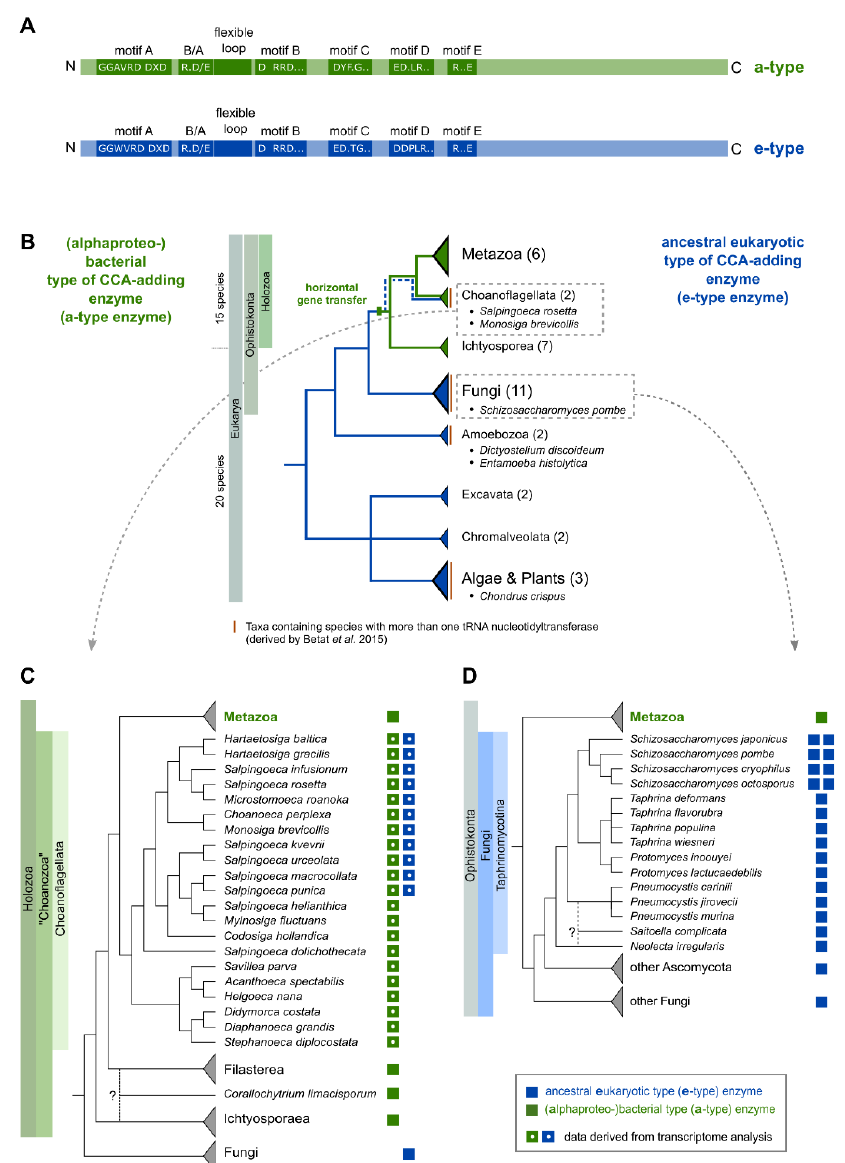
Figure 1. Phylogenetic distribution of eukaryotic species bearing genomes with more than one tRNA nucleotidyltransferase gene. ( A ) Schematic representation of class II tRNA nucleotidyltransferase organization. Motifs A to E of the catalytic core are indicated in green and blue. Additional motifs involved in A-addition are the basic / acidic motif (B / A; indicated as R (arginine) and D (aspartate), other basic / acidic combinations are also found) and the flexible loop, both located between motifs A and B. ( B ) Phylogenetic tree summarizing the data from 35 eukaryotic genomes analyzed in Betat et al. [8]. The tree topology represents all major eukaryotic clades. The total number of genomes analyzed per clade is given in brackets. Species names are given for genomes containing more than one candidate tRNA nucleotidyltransferase sequence. ( C , D ) Phylogenetic distribution of tRNA nucleotidyltransferases in Choanoflagellata and Taphrinomycotina, respectively. Boxes next to the species name indicate the type of candidate tRNA nucleotidyltransferase genes (green—alphaproteobacterial a-type; blue—ancestral eukaryotic e-type). Closed and open boxes indicate whether candidates are derived from genome or transcriptome data. The trees to the left of the species names are for illustrative purposes as the species phylogeny is not well established in some parts. Multifurcations, question marks, and dotted branches indicate uncertainty about the phylogenetic position.